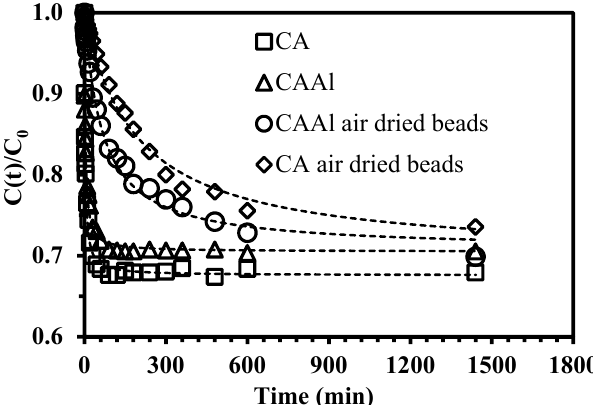
Figure 6. Boron sorption kinetics using hydrogel and air-dried beads (pH 0 : 11, equilibrium pH: 9.5–9.8, [B]initial = 50 mg · L − 1 , 1.75 g of sorbent, V = 250 mL, T room, 1 atm).